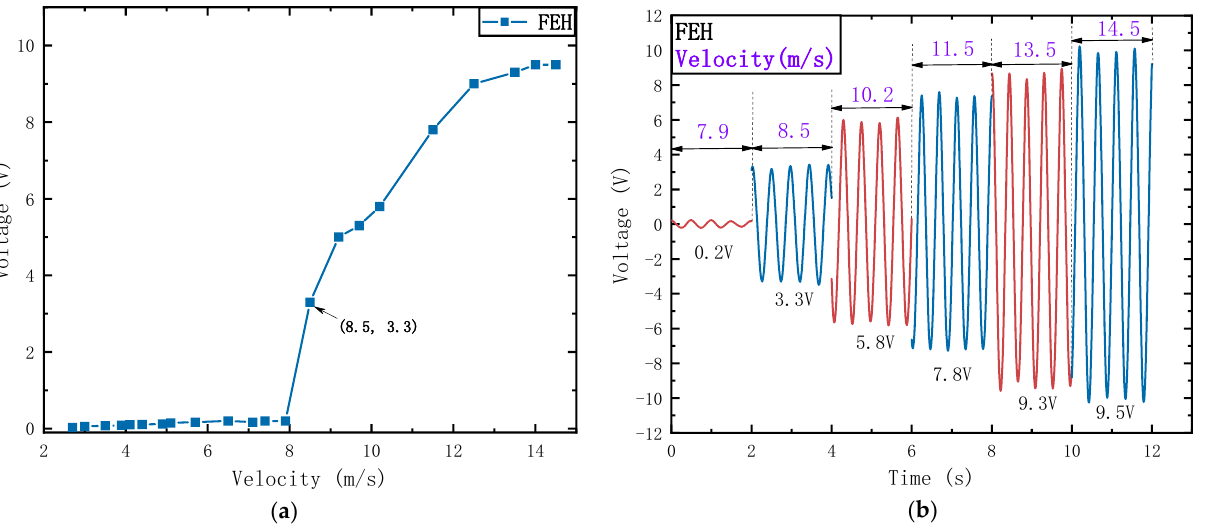
Figure 8. FEH output voltage: ( a ) Output voltage curve with wind velocity; ( b ) Voltage waveform with time.